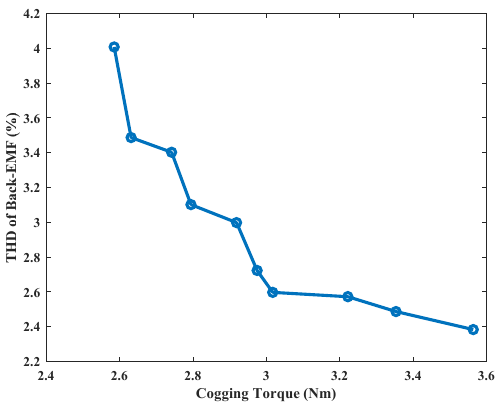
Figure 11. Pareto front set of IPMSM. Figure 12a shows the comparison of torque between the initial model and the optimal model. The average torque increases 0.47% more compared to the initial model. Figure 12b shows the comparison of back EMF. The THD of back EMF is 4.96% for the initial model and 2.70% for the optimal model, with an optimal model being 45.56% lower. Figure 12c shows a comparison of the cogging torques. The cogging torque is 4.75 Nm for the initial model and 3.45 Nm for the optimal model, with the latter being 27.37% lower.